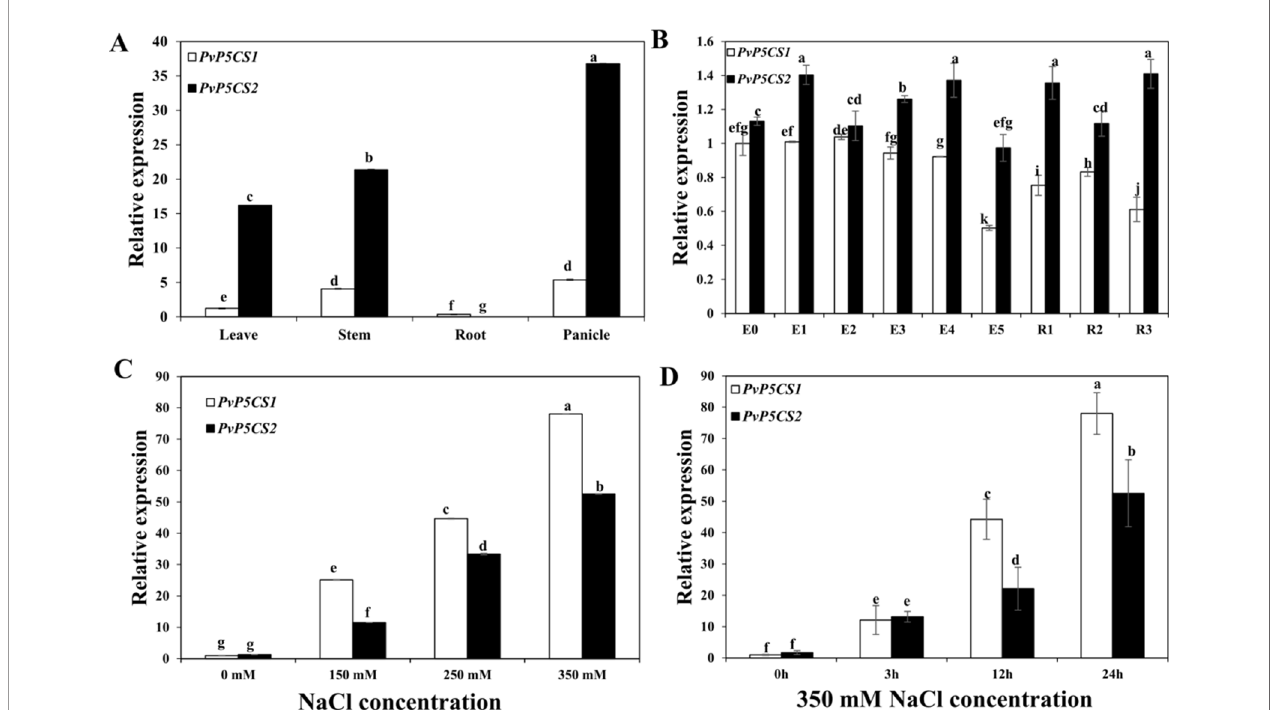
FIGURE 1 | Expression pattern of two PvP5CS genes ( PvP5CS1 and PvP5CS2 ) in switchgrass. Relative expression level of two PvP5CS genes in different tissues (A) . Relative expression level of two PvP5CS genes in different development stages (B) . Analysis of PvP5CS genes expression under different NaCl concentrations (0 mM, 150mM, 250mM, and 350mM) after 24h salt treatment (C) . Transcripts of PvP5CS genes under 350 mM NaCl at the indicated time points (D) . Switchgrass UBQ1 was used as the reference for normalization. At the fi rst stage of elongation, there in none internode, so it is de fi ned as E0. When switchgrass grows the internode, E1 to E5 are de fi ned by the number of internodes present. At the beginning of the reproductive stage, fl ag leaf comes out, and it is de fi ned as R1. When switchgrass has the fully emerged spikelets without peduncle, it arrived at R2 stage. The R3 stage is de fi ned by fully emerged spikelets and visible peduncle. Data are mean values of three biological repeat, and signi fi cance of treatments was tested at the P < 0.05 level (one way ANOVA, Dunnett's test). WT: wild type